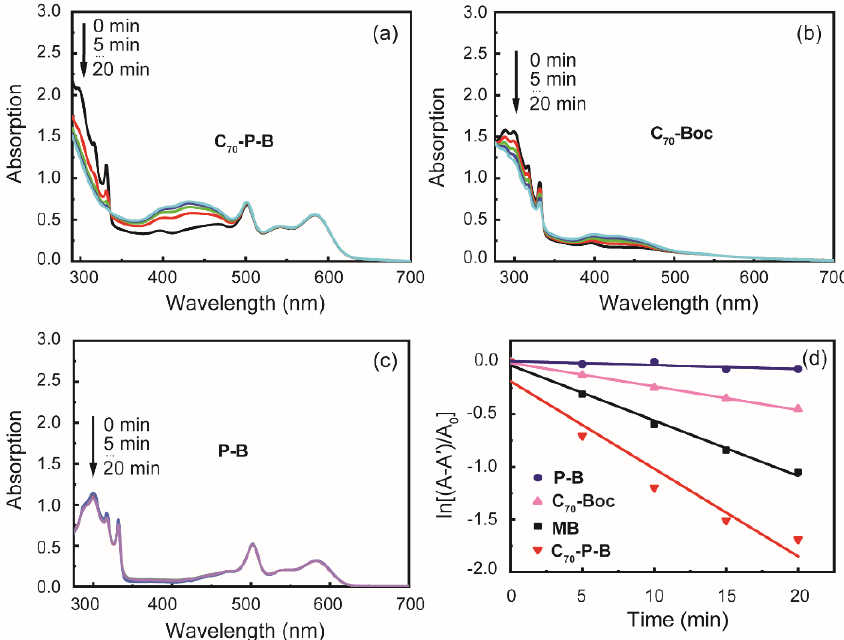
Figure 7. Absorption spectral evolution for the photooxidation of DHN using ( a ) C 70 -P-B , ( b ) C 70 - Boc and ( c ) P-B as photosensitizers. ( d ) Plots of ln[(A − A′)/A 0 ] vs. irradiation time (t) for the photooxidation of DHN using different sensitizers (collected at 301 nm). c[sensitizers] = 1.0 × 10